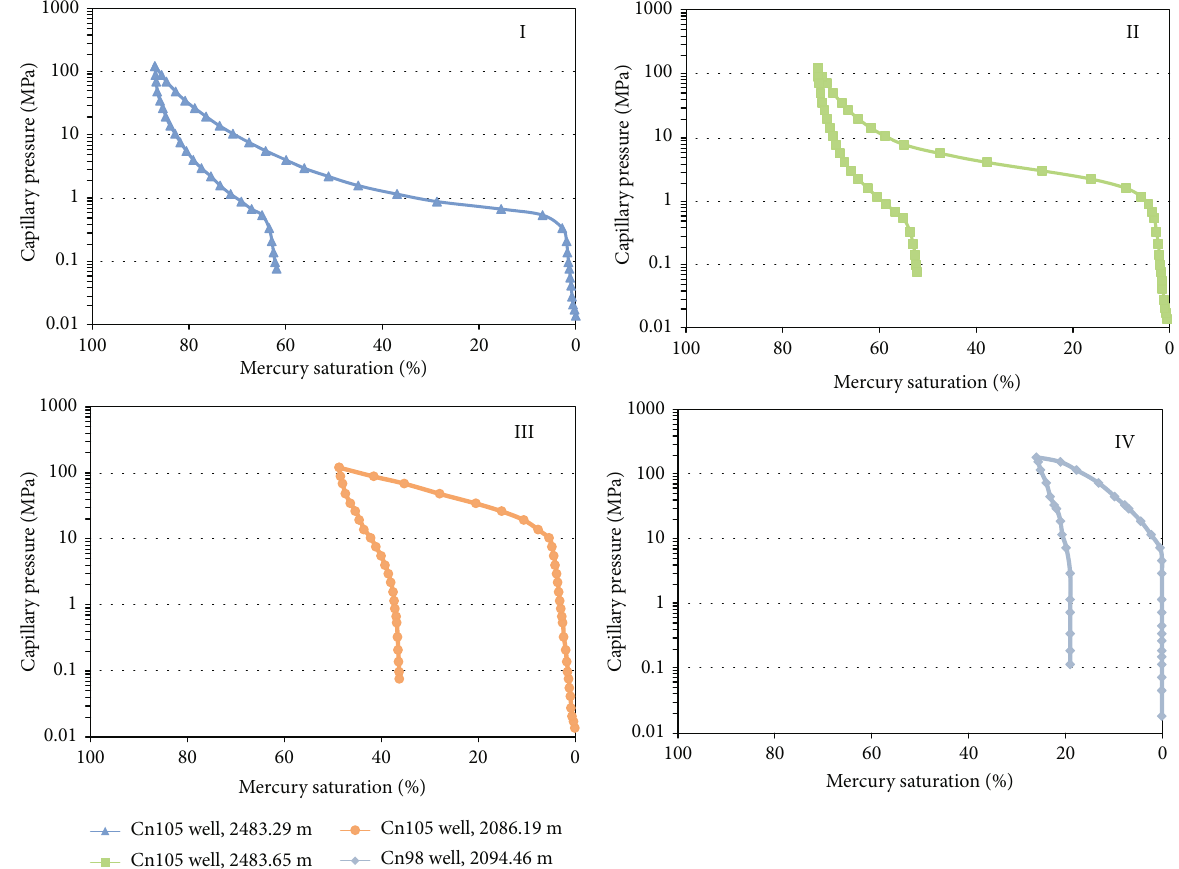
Figure 6: Capillary pressure curve characteristics of di ff erent types of